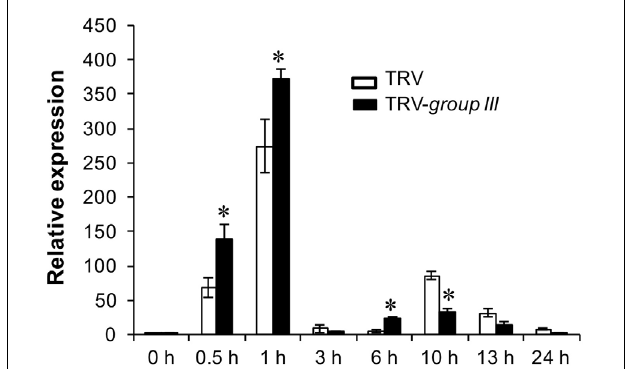
FIGURE 6 | The expression of the RbohB gene in flg22-treated N. benthamiana leaves. Real time PCR (qRT-PCR) analysis of the expression of the N. benthamiana RbohB gene at the indicated time points after treatment with 40 µ M flg22. The experiment was performed with three technical repeats in each of the three biological replicates. Asterisks denote significant difference ( P < 0.05) in the expression level of the RbohB gene on group III E2 genes-silenced and non-silenced control